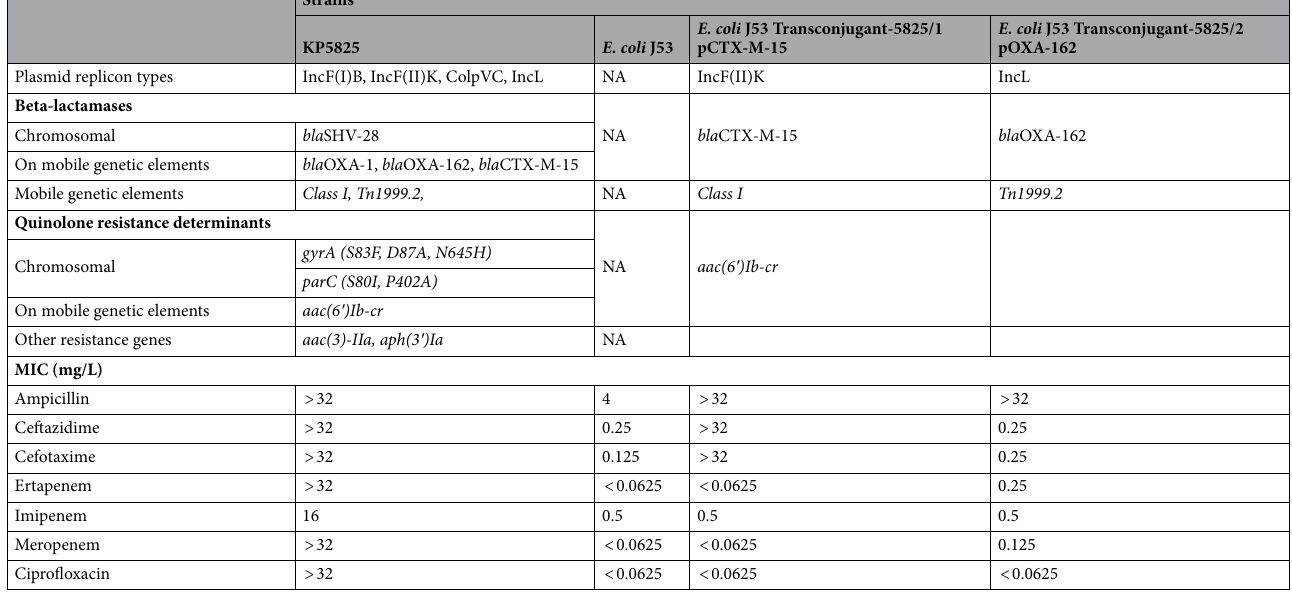
Table 1. Features of KP5825 and the transconjugated E. coli J53 strains. MIC: minimum inhibitory concentrations; NA: not